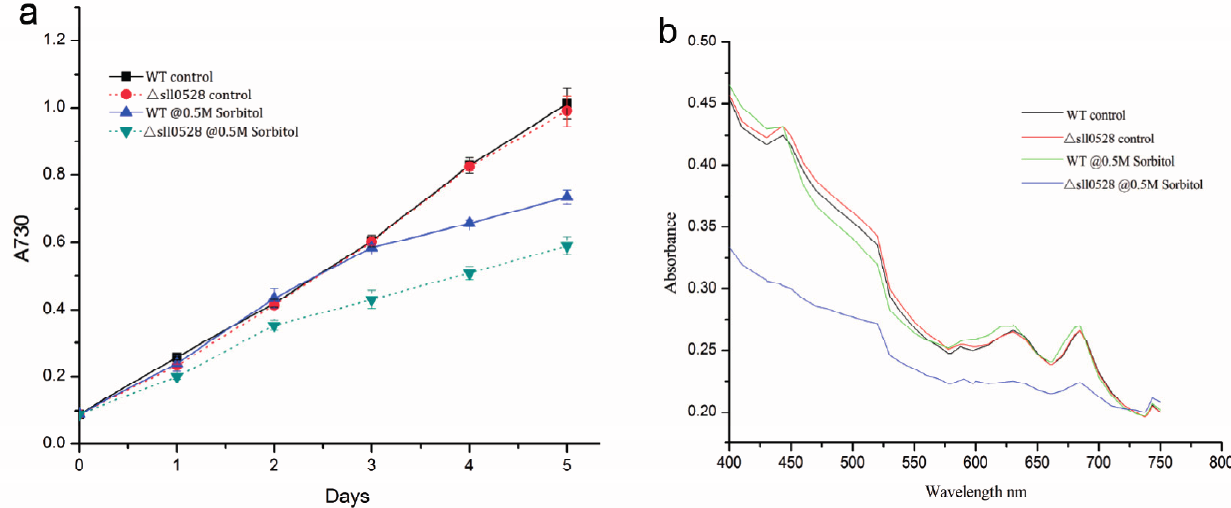
Figure 4. Increased sensitivity of sll0528 mutant to hyperosmotic stress generated by sorbitol. ( a ) Growth curve of wild type (WT) and sll0528 mutant ( Δ sll0528 ) under 0.5 M sorbitol. Initial OD 730 was 0.1. Each data point represents the mean of at least three independent biological replicates, and the error bars denote SD; ( b ) Absorption spectra of wild type and sll0528 mutant 24 h after transferred to 0.5 M sorbitol, normalized to OD 730